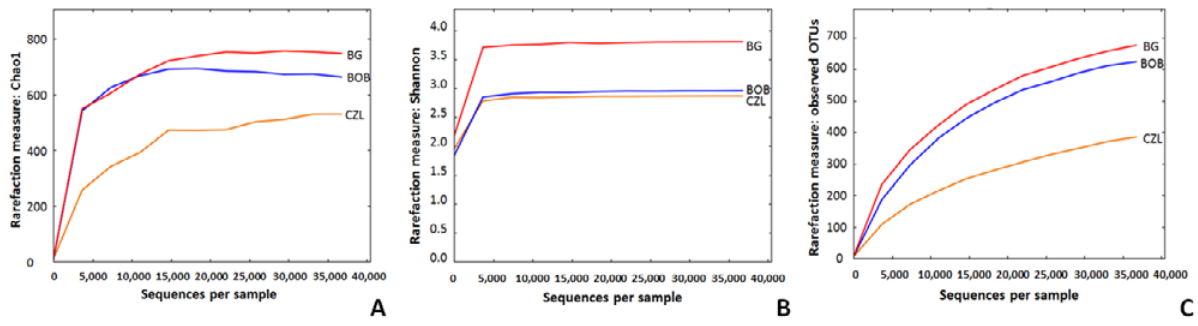
Fig. 2 Rarefaction curves presenting taxonomic richness – Chao1 ( A ) and diversity – Shannon H' index ( B ) reaching a plateau above 25,000 and 5,000 sequences, indicating that sequencing was deep enough for establishing those values. Rarefaction curves presenting observed OTUs in nectar samples are not completely saturated, suggesting the sequence identities were not fully surveyed ( C ). Rarefaction-based analyses were applied to assess the relationship between the increase in bacterial α-diversity and the number of randomly sampled sequences. Such analyses generate the expected number of OTUs, Chao1, and Shannon indices in a small col- lection of n samples drawn at random from a large pool of N samples.